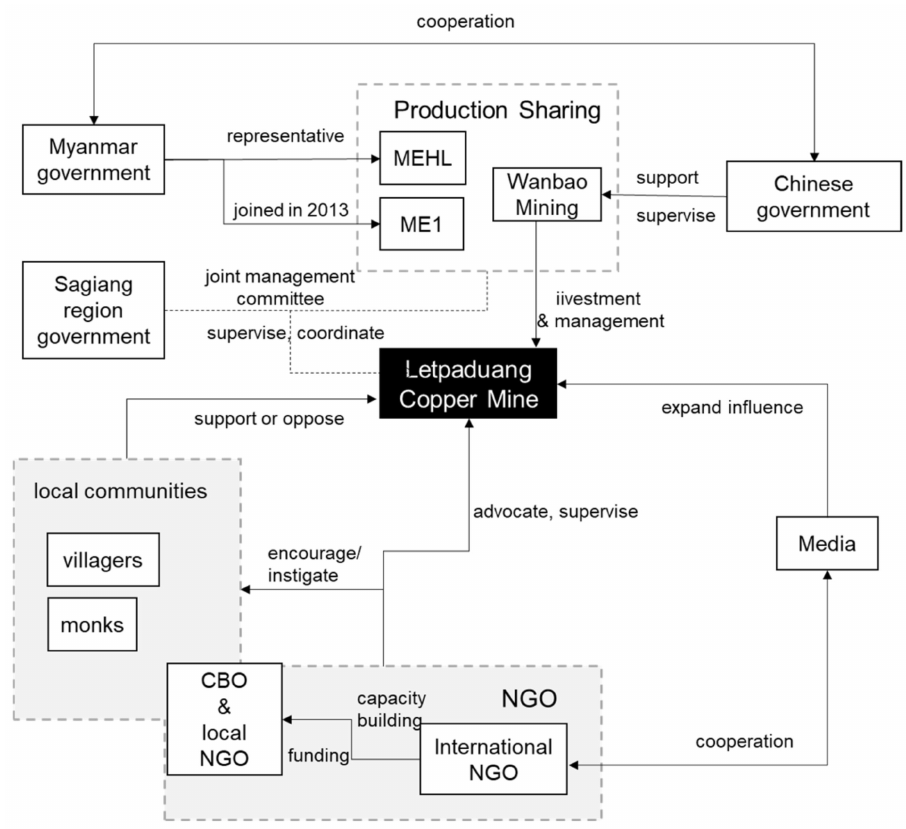
Figure 2. Bargaining network of Letpadaung Copper Mine. Source: study